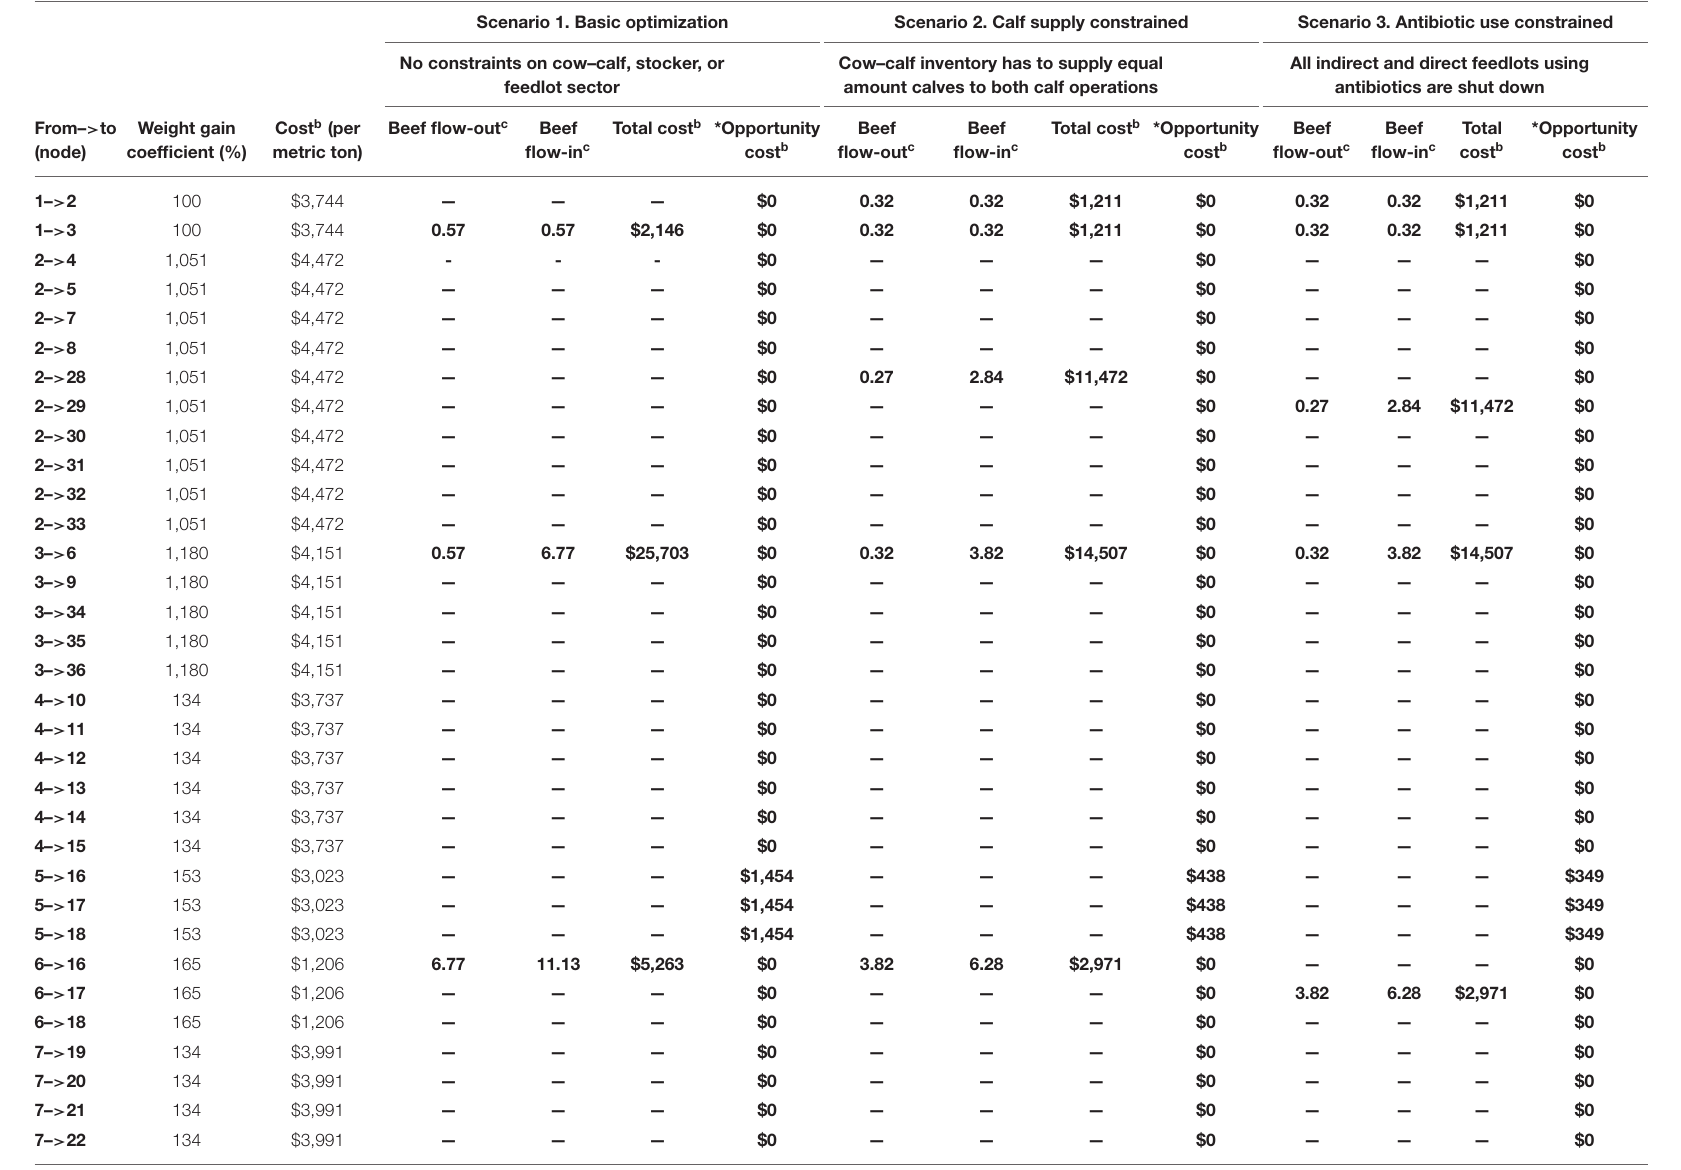
TABLE 1 | The solutions for the three linear programming scenarios a applied to integrated beef supply chain network model, each with a different antibiotic use demand constraint. Scenario 1. Basic optimization Scenario 2. Calf supply